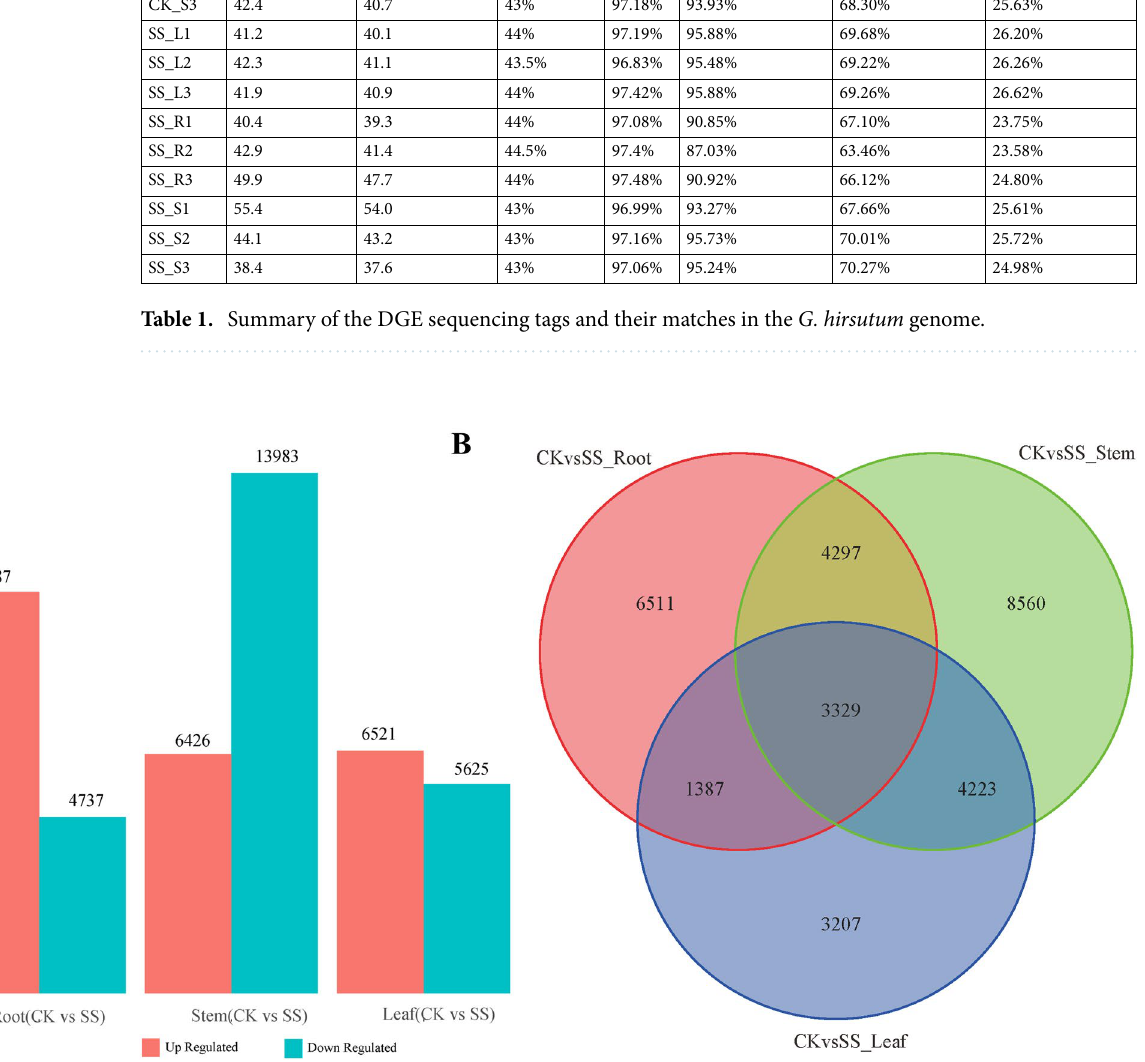
Figure 2. Expression dynamics changes and comparative analysis of differentially-expressed genes (DEGs) among CK_R, SS_R, CK_S, SS_S, CK_L, SS_L. CK: Control group; SS: 300 mM Na 2 SO 4 . (A) Number of up-regulated and down-regulated DEGs of each sample between SS and CK. (B) Number of DEGs among roots, stems and leaves under SS and CK